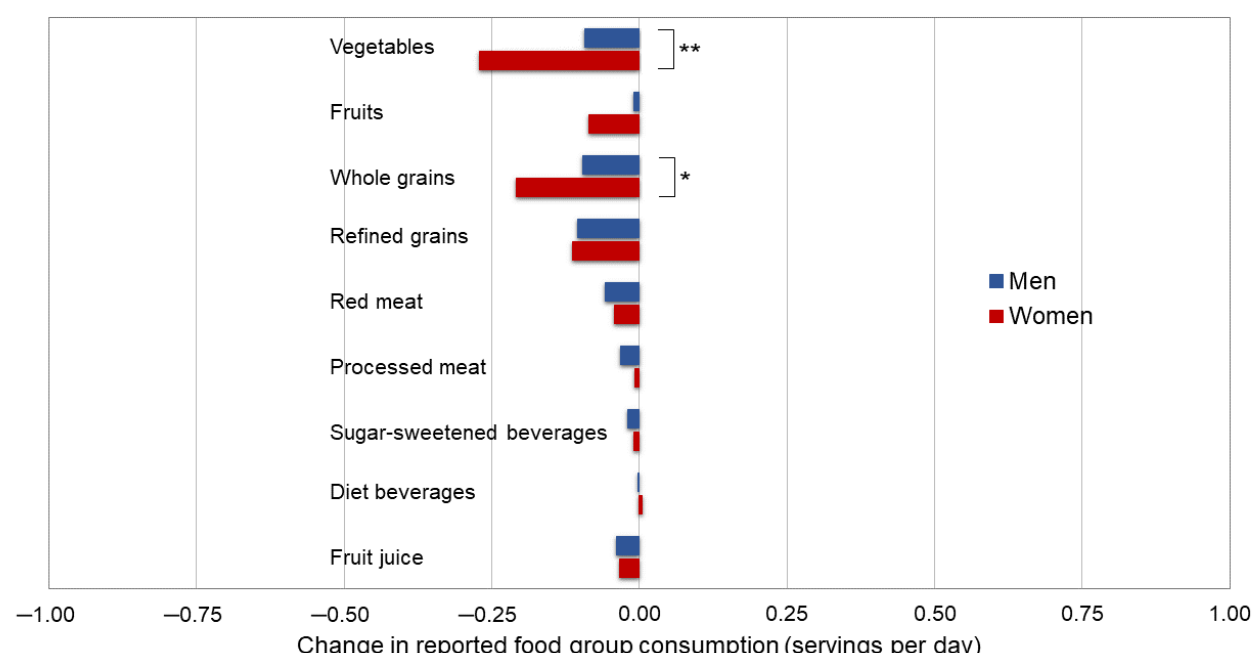
Figure 1. Mean change in individual food group consumption (servings per day) from before (2018) to during (July/Aug 2020) the COVID-19 pandemic among a subgroup of Cancer Prevention Study-3 cohort participants, stratified by sex (N = 2335). p -values between strata were examined by t -tests and are presented using an asterisk for p < 0.05 and two asterisks for p < 0.001. There were no statistically significant differences in changes in overall diet quality scores across racial/ethnic groups ( p = 0.58), which significantly improved only among White participants (0.24 points, p < 0.001; Table S3). There was a statistically significant take decreased the most among Black participants ( − 0.40 servings/day, p = 0.03).